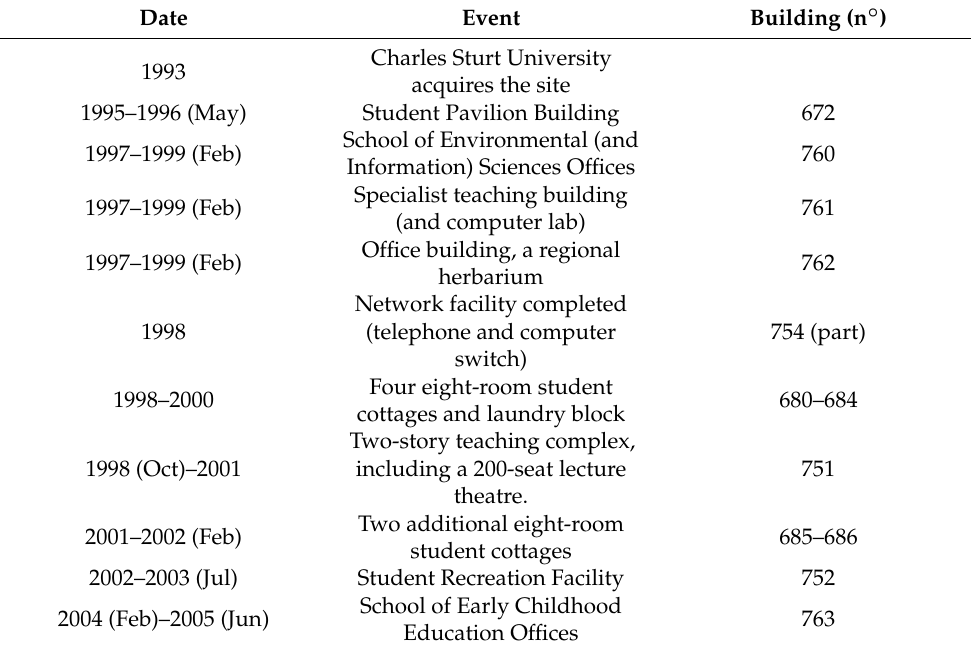
Figure 5. The eastern wing of the Environmental Sciences building (Bldg 760) as seen from northwest. Table 1. Chronology of rammed earth structures erected at Charles Sturt University Campus, Thur- goona, NSW,